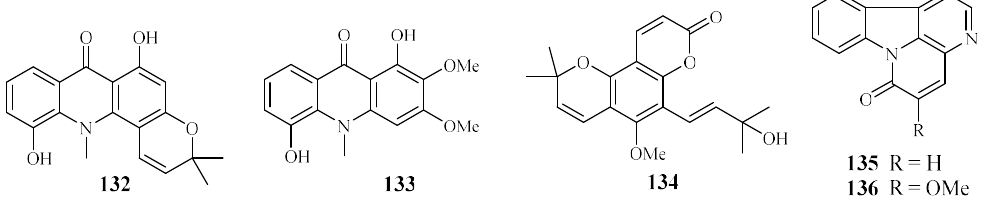
Figure 30. Compounds from Rutaceae plants.